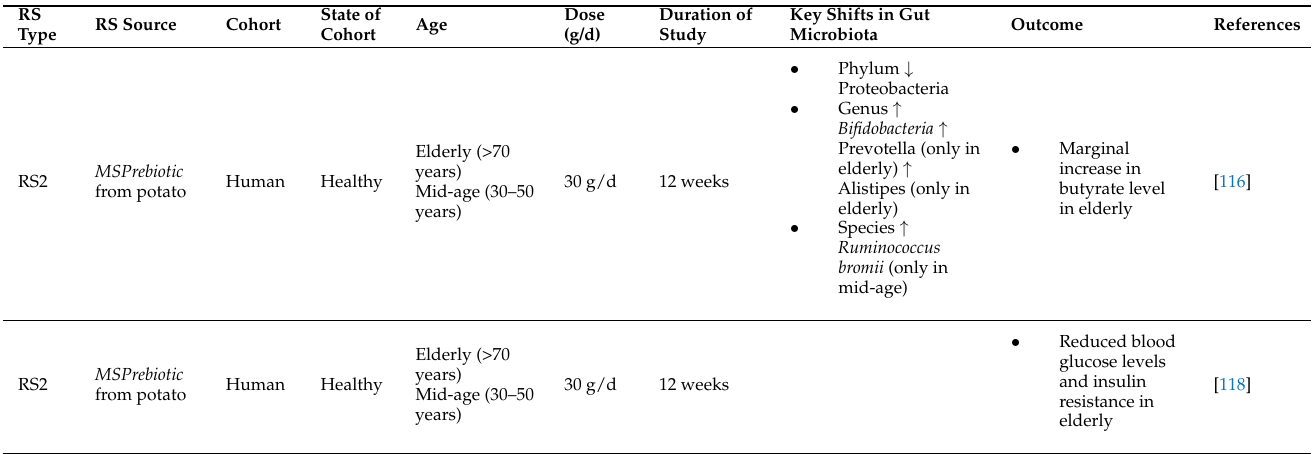
Figure 2. Illustration depicting the reported and purported beneficial effects of resistant starch (RS) on aging-associated gut microbiota and metabolic health. SCFA: short-chain fatty acids; LPS: lipopolysaccharide; IBD: inflammatory bowel disease; IL: interleukin; TNF: tumor necrosis factor; : stimulation; ↑ : increased; ↓ : decreased. Table 4. Effect of dietary resistant starches on aging-associated gut microbiota and health